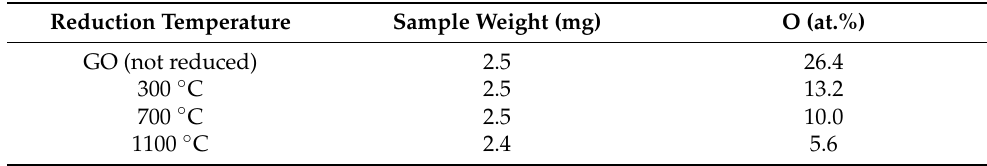
Figure 7. Water contact angle measurements for the epoxy resin coatings: ( a ) without GN; ( b ) with 0.05 wt.% of GN. (The scale bars for ( a ) and ( b ) are the same.). Table 3. Oxygen contents for GO and different GN